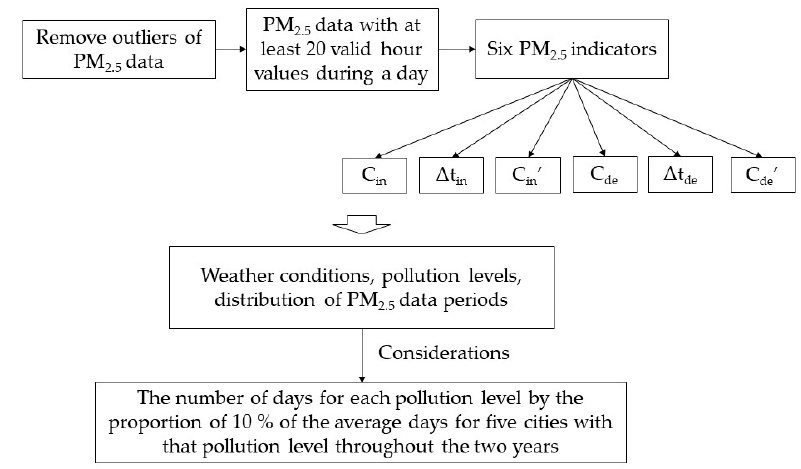
Figure 2. The process of PM 2.5 data.